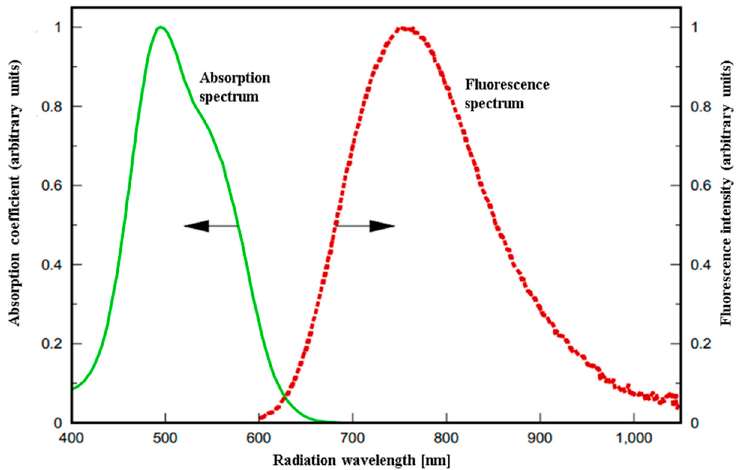
Figure 5. The absorption (green line) and fluorescence (red line) bands of Ti:sapphire crystals.